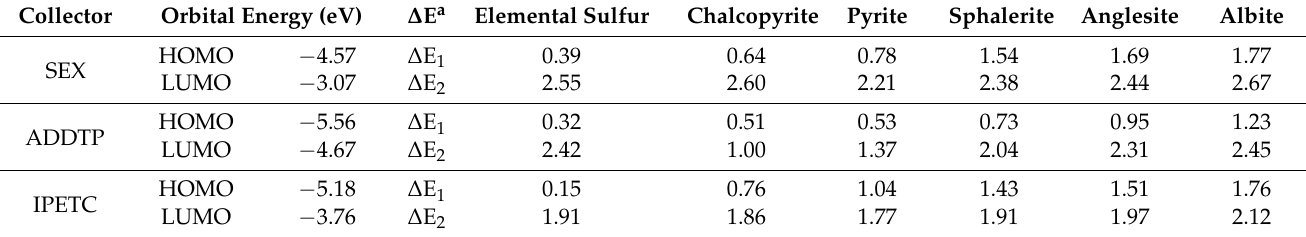
Table 9. Frontier orbital energies of collectors and energy differences between collectors and minerals.